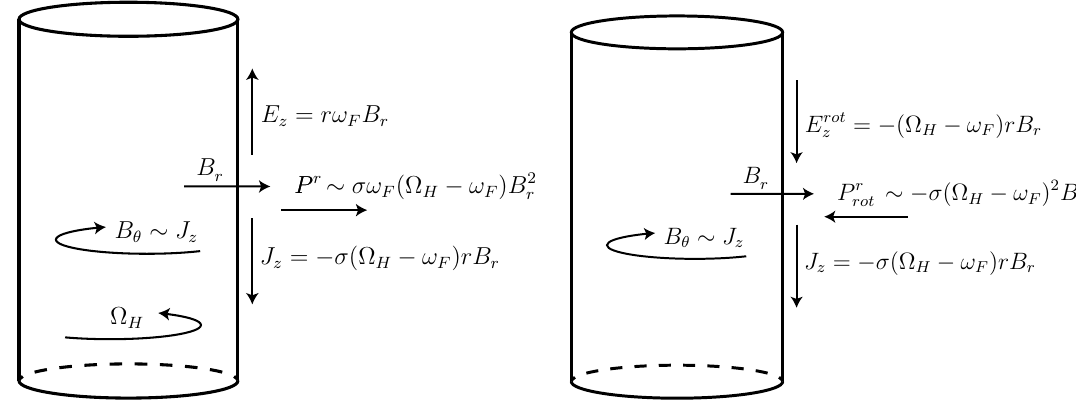
Figure 1 . Toy model set-up of a rotating conducting cylinder in the lab frame (left) and a frame that rotates with the cylinder